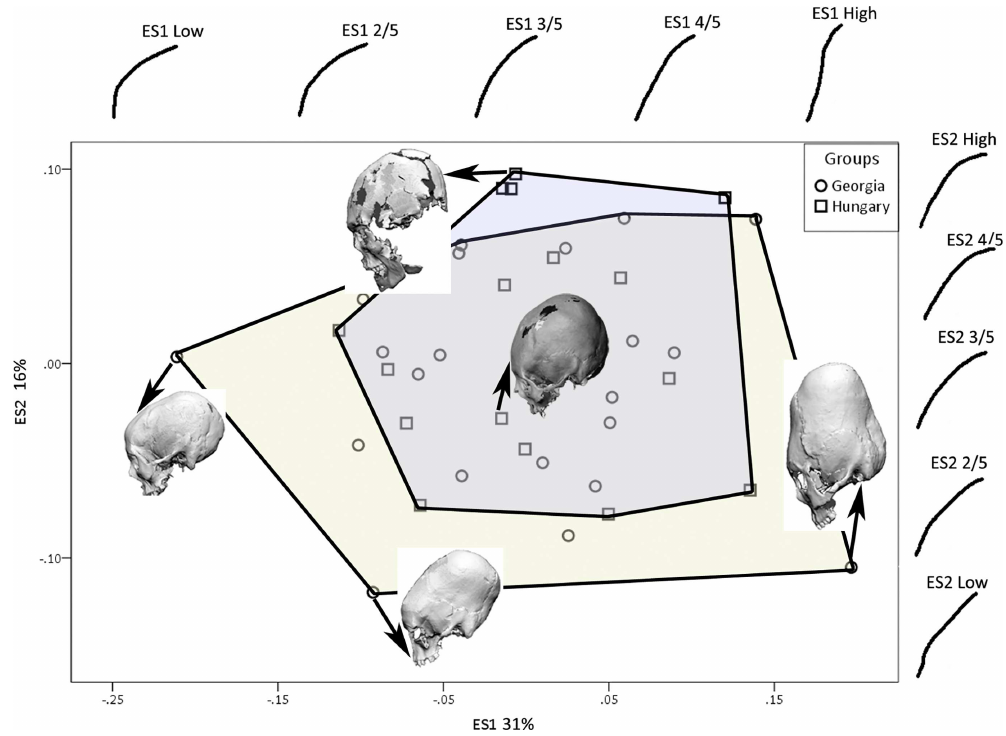
Fig 10. Eigenscores for the frontal outline plotted on ES1 and ES2 with convex hulls highlighting each group, also showing shape changes along the first and second morphospaces, and example crania demonstrating the variance.